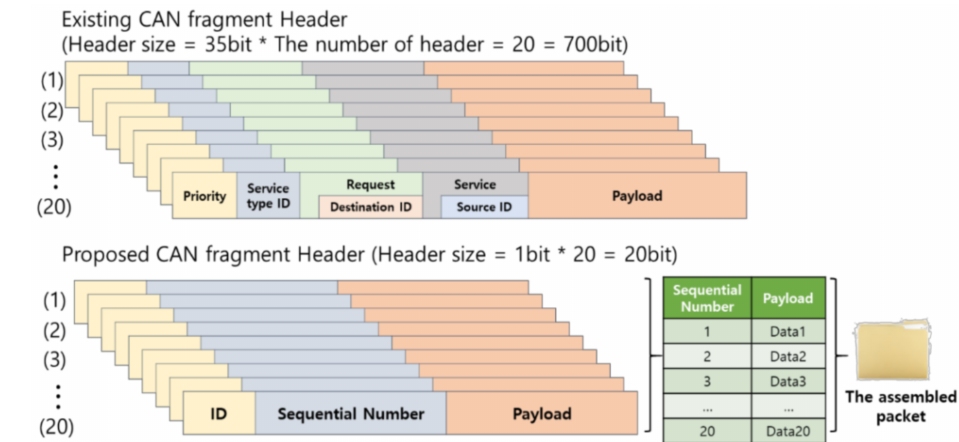
Figure 5. CAN fragment Header and fragment assembly process in the In-VGM.